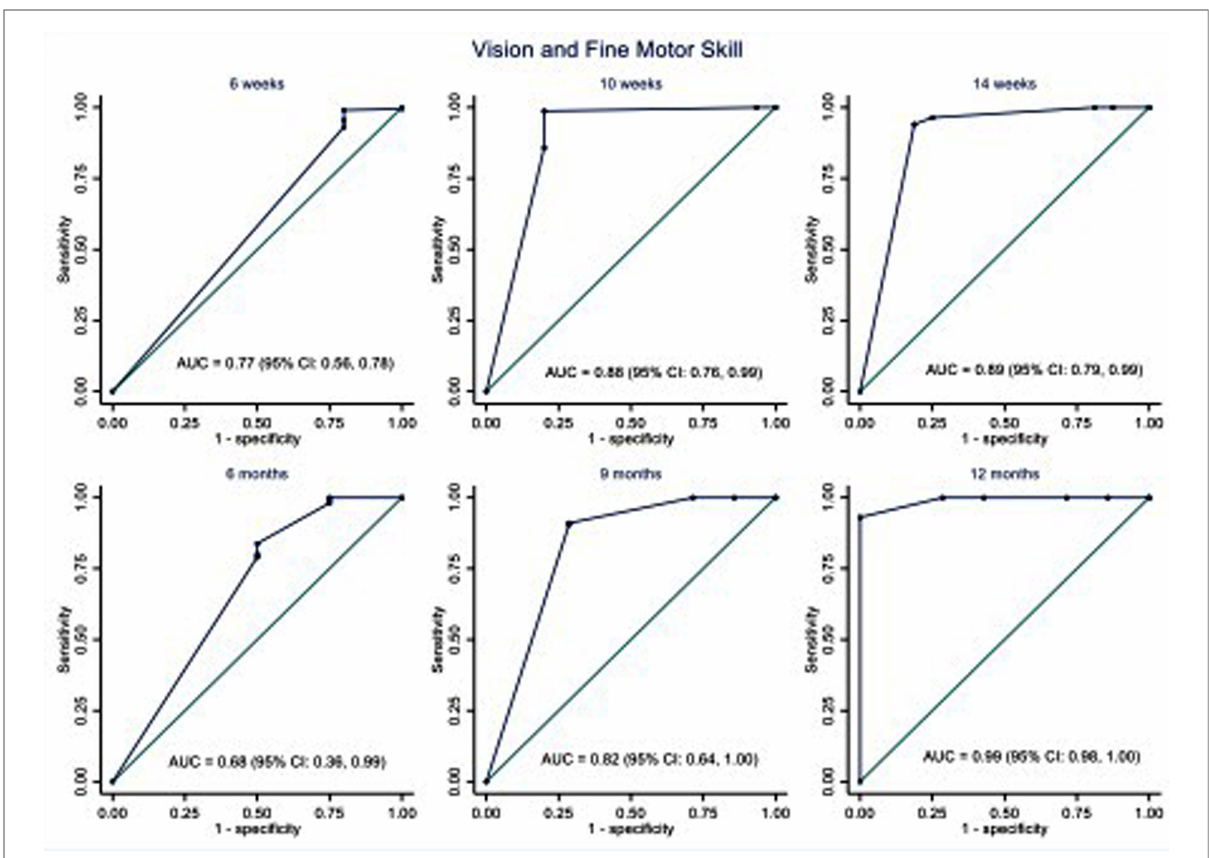
FIGURE 3 ROC curves showing the performance of ISDS in the detection of delay in vision and fi ne motor domain at the age-speci fi c optimal